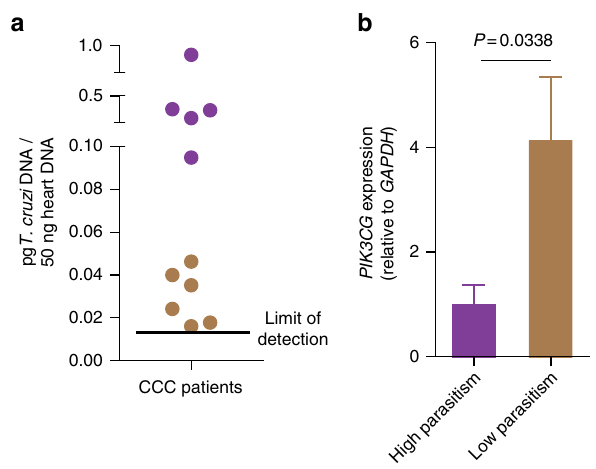
Fig. 10 Relationship between parasitism and PI3K γ expression in the heart tissue of CCC patients. a Quantitative real-time PCR analysis of T . cruzi DNA levels (pg/50 ng of human DNA) in heart tissue from CCC patients. The black line indicates the lowest amount of parasite detected by